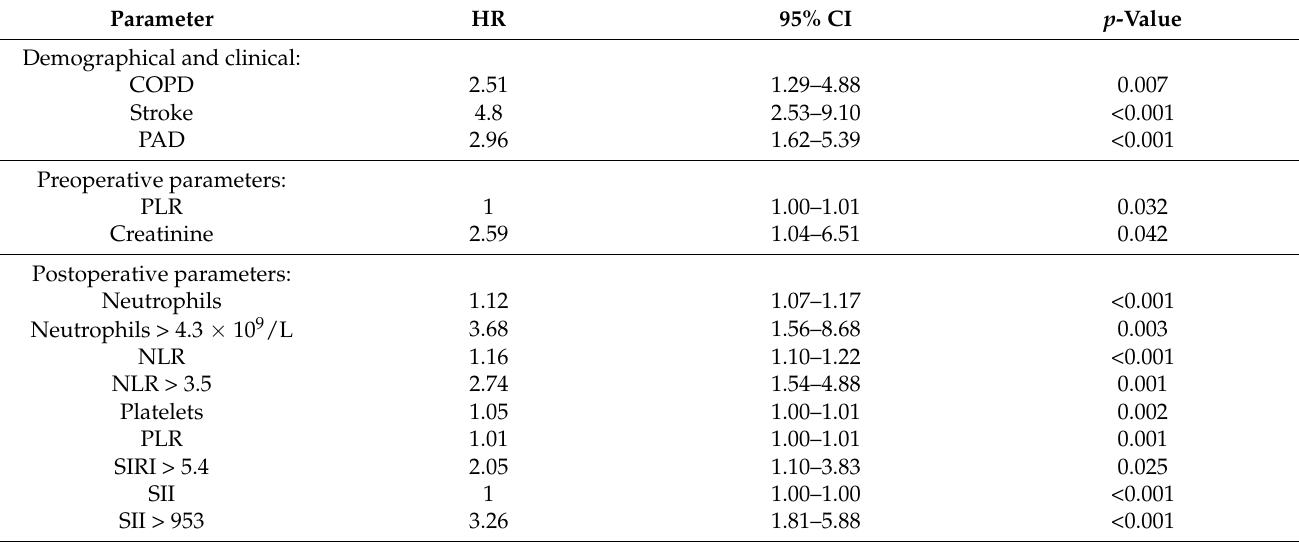
Table 3. Cox regression univariable analysis for long-term survival.